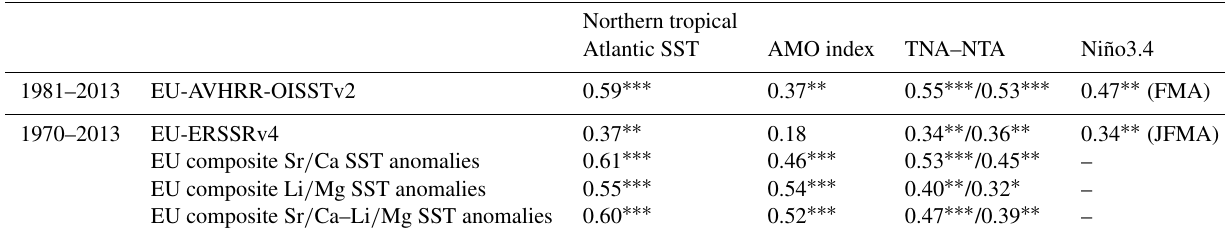
Table 4. Linear correlation of detrended, mean annual instrumental and coral composite proxy-based SST for Europa (EU) with northern tropical Atlantic SST, the AMO index based on ERSSTv4, the tropical North Atlantic (TNA; Enfield et al., 1999) and north tropical Atlantic index (Penland and Matrosova, 1998), and the seasonal Niño3.4 index between 1970 and 2012 (Kaplan et al., 1998). Northern tropical Atlantic